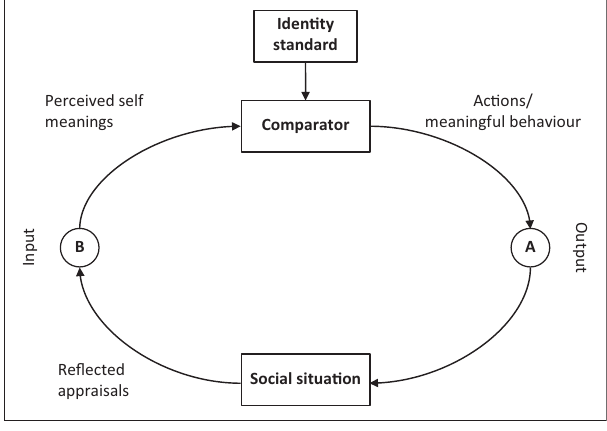
FIGURE 1: Burke’s cybernetic control